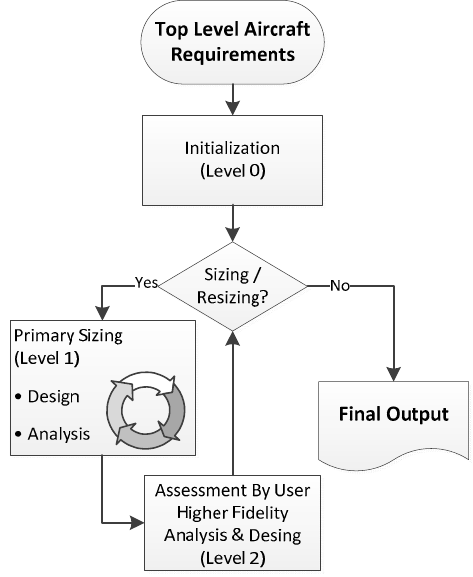
Figure 3. Flowchart of the main functions of the design environment.